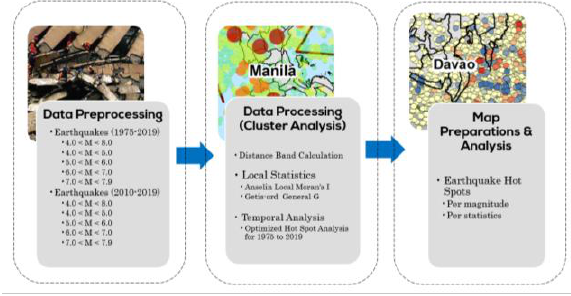
Figure 2. Methodology for Geostatistical and Cluster